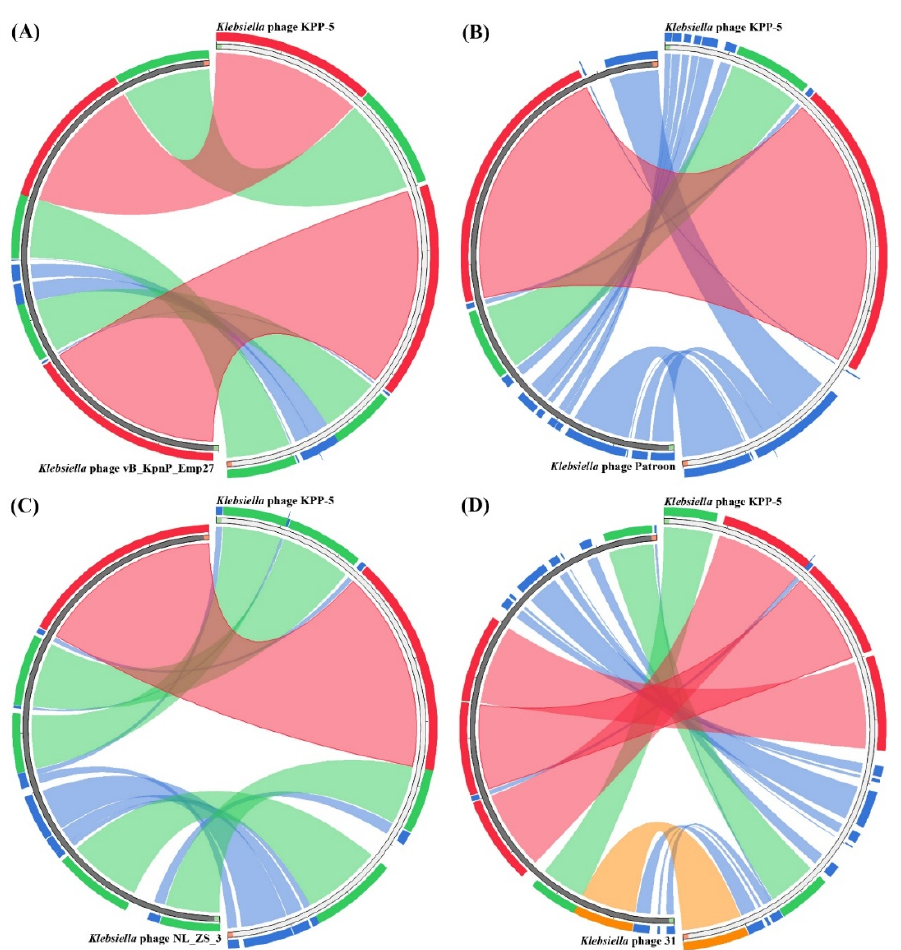
Figure 4. Circos plot depicting sequence similarities of Klebsiella phage Kpp-5 against Klebsiella phage vB_KpnP_Emp27 ( A ), Klebsiella phage Patroon ( B ), Klebsiella phage NL_ZS_3 ( C ), and Klebsiella phage 31 ( D ). The red color signifies a high sequence similarity followed by orange, green, and blue. Ratio coloring with blue ≤ 0.25, green ≤ 0.50, orange ≤ 0.75, and red > 0.75. The core genes of KPP-5, vB_KpnP_Emp27, Patroon, NL_ZS_3, and 31 phages were examined, and 34 genes were conserved in their genomes (Table S5), while 36 genes were found to be conserved in the genomes of four high-identity phages, including phage KPP-5, vB_KpnP_Emp27, Patroon, and NL_ZS_3 (Table S5). Interestingly, 37 genes were found to be conserved in the genomes of the two KPP-5 and vB_KpnP_Emp27 phages that exhibited high identity and query coverage (Table S). The gene products of these 37 genes were 14 predicted to encode proteins for replication, regulation, transcription, and translation; 3 predicted to encode proteins for host cell lysis; 12 predicted to encode proteins for the phage structure; 2 predicted to encode proteins for DNA packaging; and 6 predicted to encode proteins for unknown functions (hypothetical proteins) (Tables S3 and S5). Three distinct genes in the KPP-5 phage genome were shown in the comparison between the KPP-5 and vB-KpnP-Emp27 phage genomes, including gp 2 (GenBank No. QSJ04722), gp 9 (GenBank No. QSJ04729), and gp 35 (GenBank No. QSJ04755), which were predicted to encode hypothetical proteins (Tables S3 and